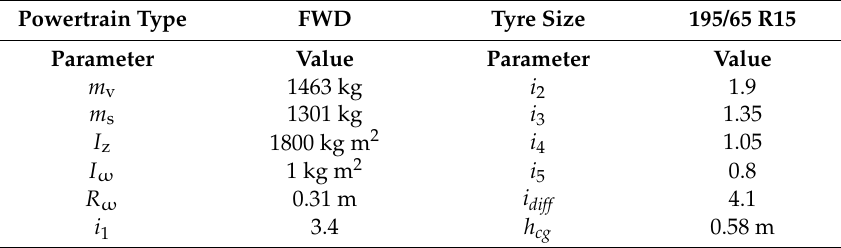
Table 1. Vehicle parameters used for the simulation.